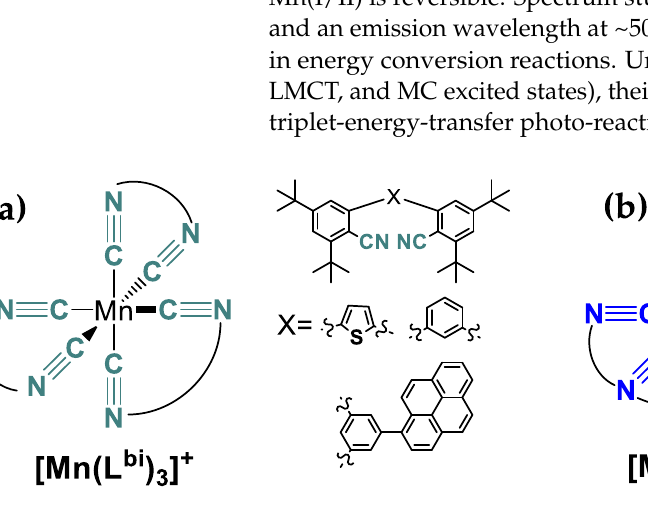
Figure 7. Chemical structures of the ( a ) [Mn(L bi ) 3 ] + -based and ( b ) [Mn(L tri ) 2 ] + -based photosensitizers and corresponding ligands in this review.